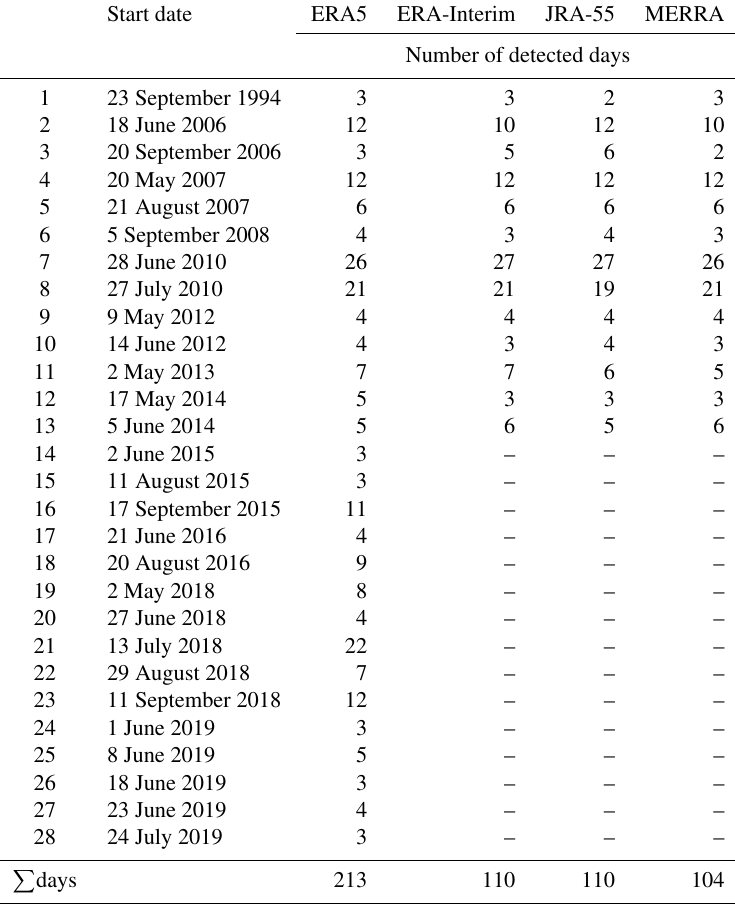
Table 1. Heat waves in Eurasia during May–September